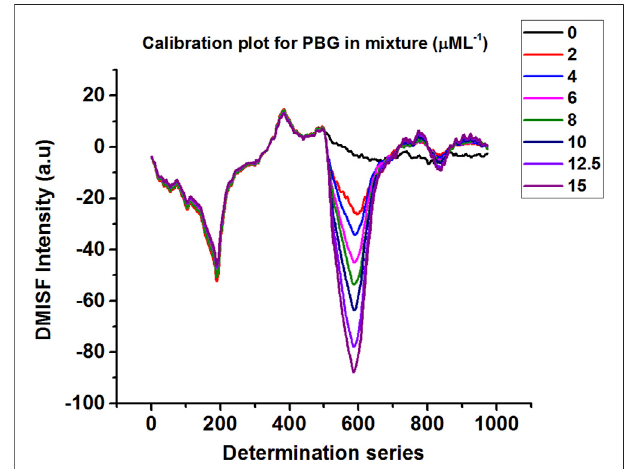
FIGURE 4 | DMISF spectra of δ -ALA (2.5 μ mol L − 1 , red solid line), PBG (6.5 μ mol L − 1 , green solid line), and their mixture, black dotted line. (A,B) refer to the detection points of δ -ALA and PBG respectively.